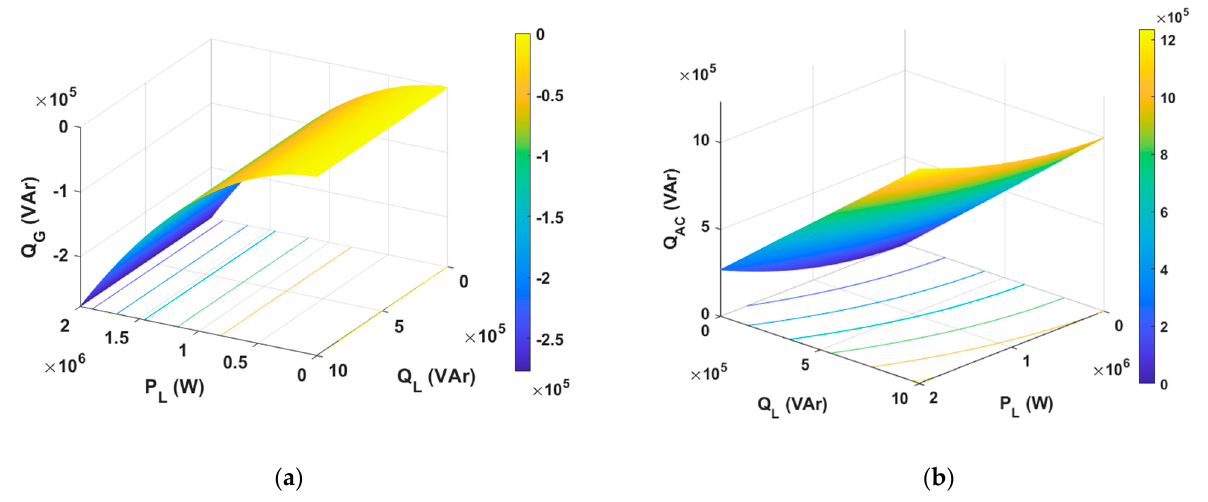
Figure 10. Reactive power in the generator ( a ) and active converter ( b ).